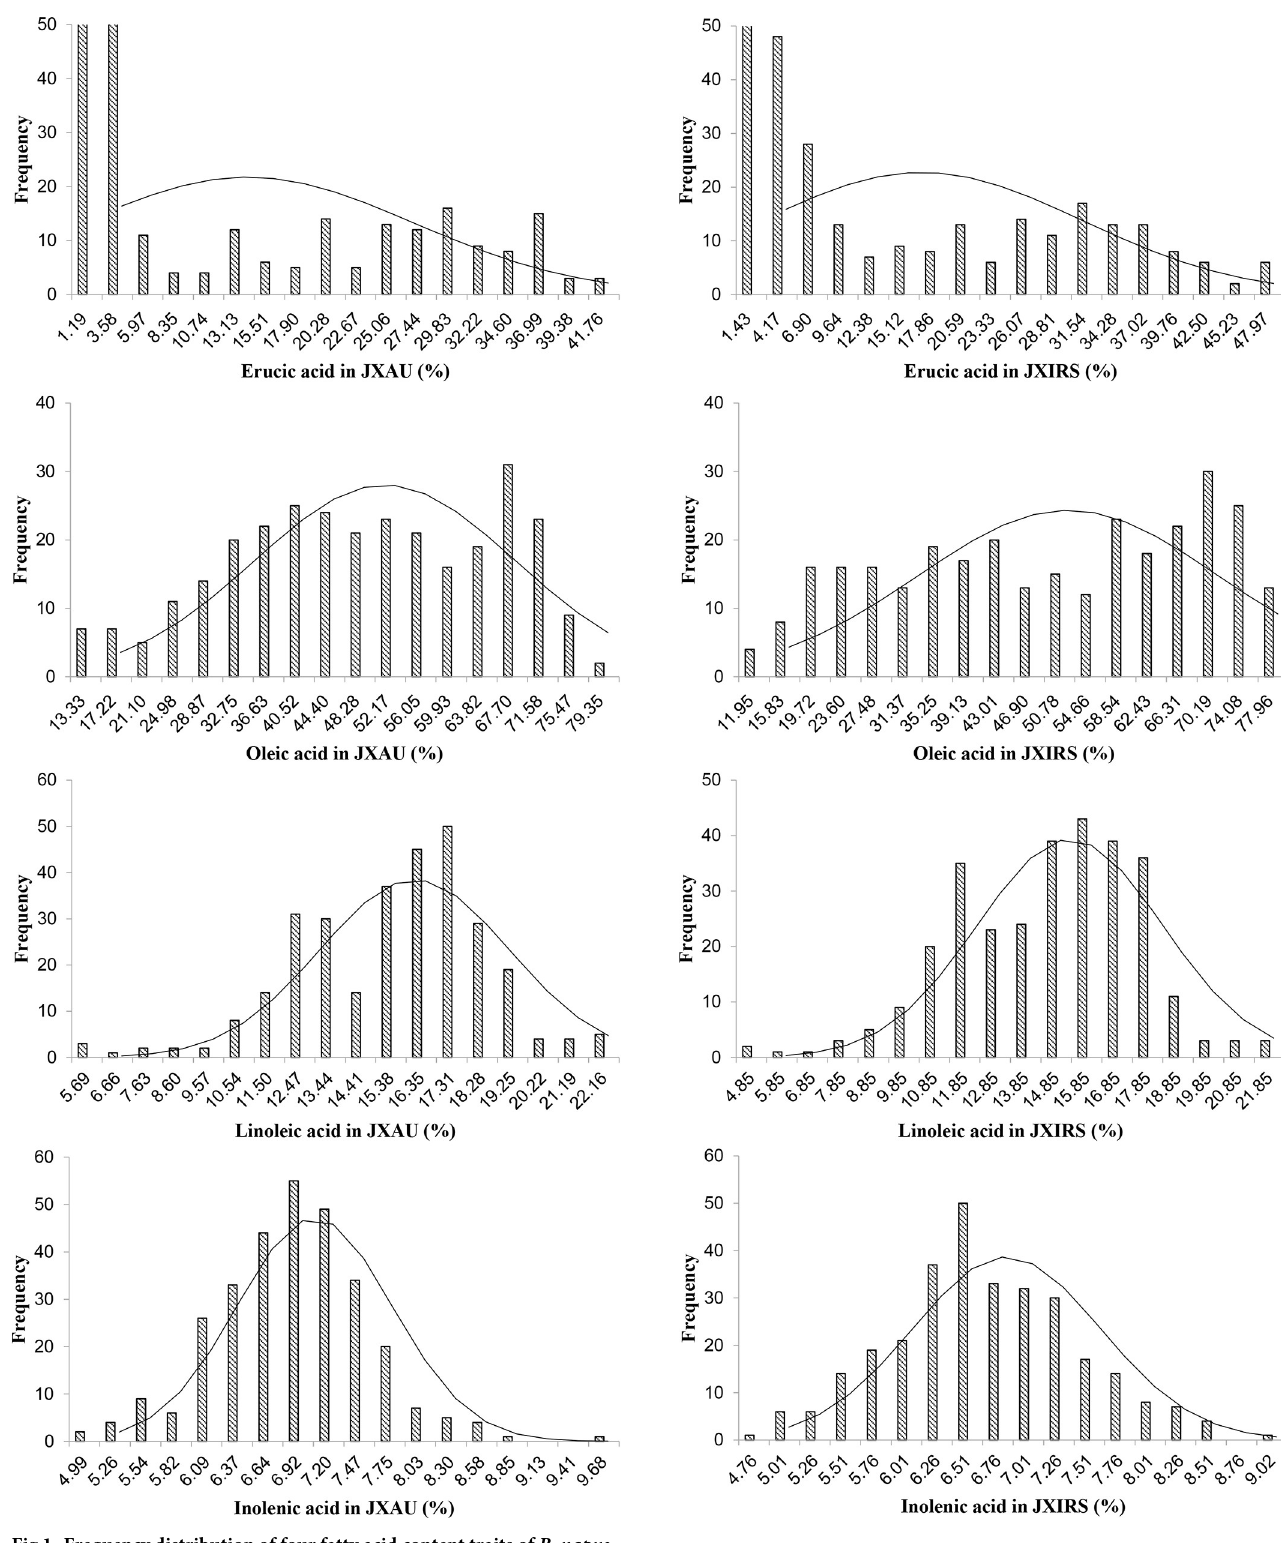
Fig 1. Frequency distribution of four fatty acid content traits of B . napus .